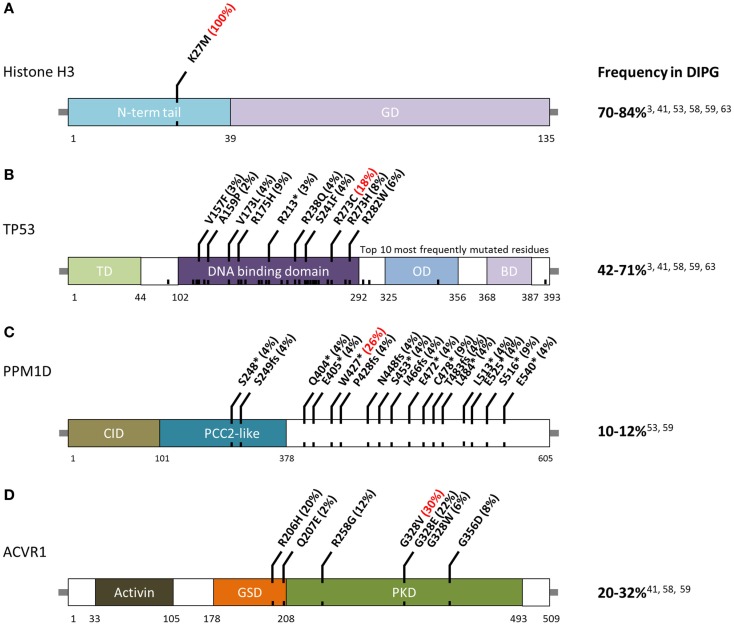
Schematic of residue alterations in (A) histone H3, (B) TP53, (C) PPM1D, and (D) ACVR1 as a result of mutations most frequently identified in DIPG. GD, globular domain; TD, transactivation domain; OD, oligomerization domain; BD, basic domain; CID, CHEK1 interacting domain; GSD, GS domain; PKD, protein Kinase domain. Red indicates most frequently altered amino acid.